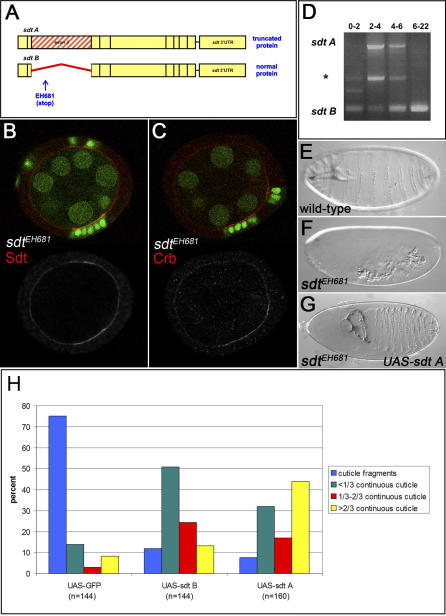

sdt A Is Specifically Required for the Early Formation of Embryonic Epithelia(A) The sdtEH681 allele contains a stop codon within the alternatively spliced exon 3.(B and C) Wild-type cells are marked with GFP (green). In sdtEH681 mutant FCs clones, Sdt (B) and Crb (C) are both reduced at the apical surface.(D) Reverse transcriptase-PCR with primers flanking exon 3, showing the relative distribution of sdt A and sdt B transcripts at different developmental time points in embryos. Asterisk marks a non-specific band. The fragmented cuticle of sdtEH681 embryos (F) when compared to wild-type embryos (E) demonstrates a strong loss of apico–basal polarity in embryonic epithelia.(G) A sdtEH681 mutant embryo in which the UAS-sdt A transgene has rescued more than two-thirds of the embryonic cuticle.(H) Graph demonstrating that a UAS-sdt A transgene is more efficient at rescuing the sdtEH681 cuticle phenotype than a UAS-sdt B transgene or the negative control, UAS-GFP transgene.